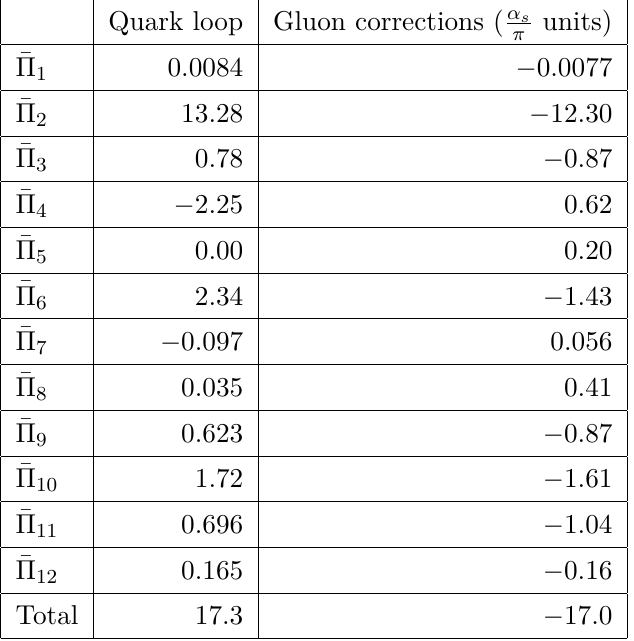
Table 4 . Leading contributions to the ( g − 2) µ integration from Q min = 1 GeV in 10 − 11